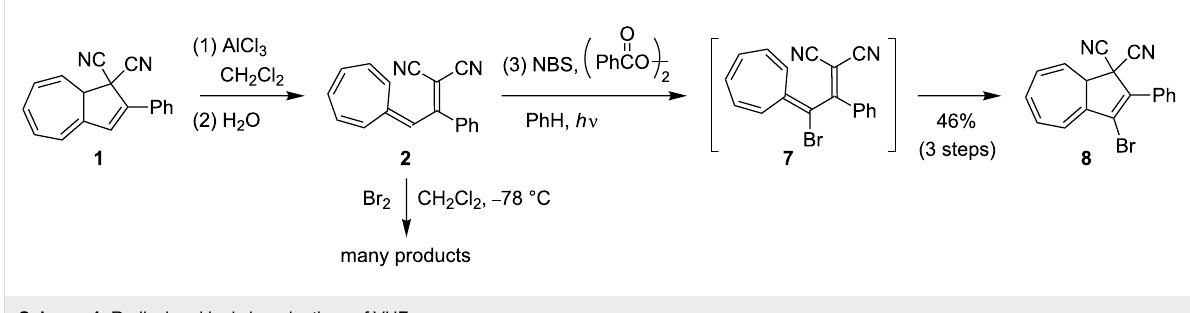
Scheme 4: Radical and ionic brominations of VHF.